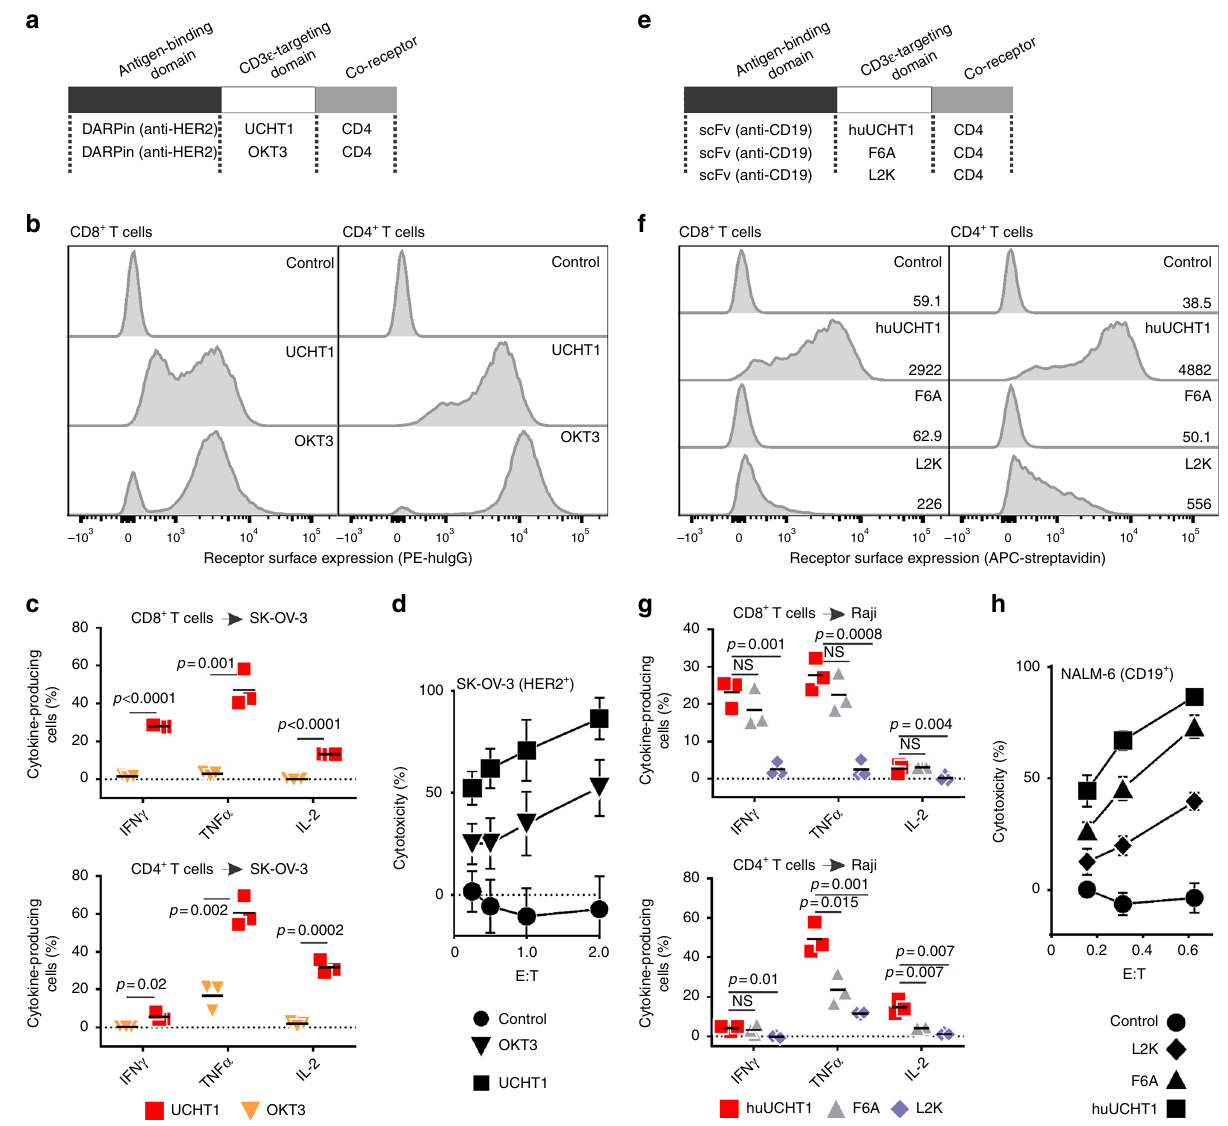
Fig. 2 Evaluation of multiple anti-CD3 scFv domains for recruitment of TAC to the TCR-CD3 complex. a , e Schematic representation of evaluated TAC constructs. TAC receptors utilizing the ( a ) anti-HER2 DARPin are paired with either the UCHT1 or OKT3 anti-CD3 scFv. TAC receptors using the ( e ) anti- CD19 scFv are paired with either the huUCHT1, F6A, or L2K anti-CD3 scFv. b , f Relative TAC surface expression is measured by fl ow cytometry. Cells are stained for CD4, CD8, tNGFR and TAC, and gated on either CD4 + NGFR + or CD8 + NGFR + . Representative data of three independent experiments are presented as histogram analysis of ( b ) HER2-TAC or ( f ) CD19-TAC. Surface expression of OKT3 relative to UCHT1 was signi fi cantly higher in CD4 cells ( p = 0.0007) but not in CD8 cells. huUCHT1 expression is signi fi cantly higher compared to either L2K ( p = 0.005 (CD4)/0.0002 (CD8)) or F6A ( p < 0.0001 (CD4) p < 0.0001 (CD8)). For the gating strategy see Supplementary Fig. 13A. c , g HER2- and CD19-speci fi c TAC-T cells are stimulated with antigen-positive ( c ) SK-OV-3 and ( g ) Raji tumor cells, respectively. Data are presented as percent of CD4 or CD8 T cells producing cytokine. Cytokine producing cells are compared from ( c ) TAC-T cells bearing UCHT1 (square) or OKT3 (inverted triangle), or ( g ) TAC-T cells bearing huUCHT1 (square), F6A (triangle), or L2K (diamond). Lines represent the mean. Multiple t -test is used to determine signi fi cance in all cases. For the gating strategy see Supplementary Fig. 13B. d , h HER2- and CD19-TAC and vector control (vector only carrying tNGFR) T cells are co-cultured with ( d ) SK-OV-3 and ( h ) NALM-6 tumor cells, respectively, to measure TAC-T cell-mediated cytotoxicity. Vector control T cells (circles) are compared against d HER2-speci fi c TAC-T cells bearing UCHT1 (square) or OKT3 (triangle), or ( h ) CD19-speci fi c TAC-T cells bearing huUCHT1 (square), F6A (triangle), or L2K (diamond). Data are from three independent experiments with three different donors, error bars are standard either a fi rst-generation or a CD28-based, second-generation (Fig. 5a – d). Consistent with the earlier data, tumors treated with HER2-CAR 31 ; all chimeric receptors were targeted against HER2 HER2-TAC-T cells regressed within a few days following T cell with the same DARPin. All engineered T cells displayed com- infusion (Fig. 5a). In striking contrast, fi rst-generation HER2- parable in vitro cytotoxicity and cytokine production (Supple- CAR-T cells showed no anti-tumor activity and tumor progres- mentary Fig. 6A – F). These in vitro similarities notwithstanding, sion was not signi fi cantly different from control treated mice we observed marked differences in the anti-tumor activity of (Fig. 5b). Second-generation HER2-CAR-T cells displayed only HER2-TAC- and HER2-CAR-engineered T cells in vivo moderate, delayed anti-tumor ef fi cacy which manifested around